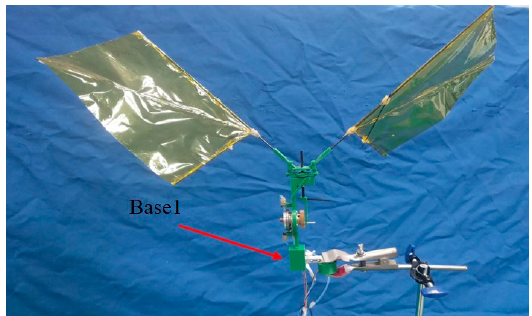
Figure 10. The flapping wing rotor (FWR) experimental model mounted on a load cell.